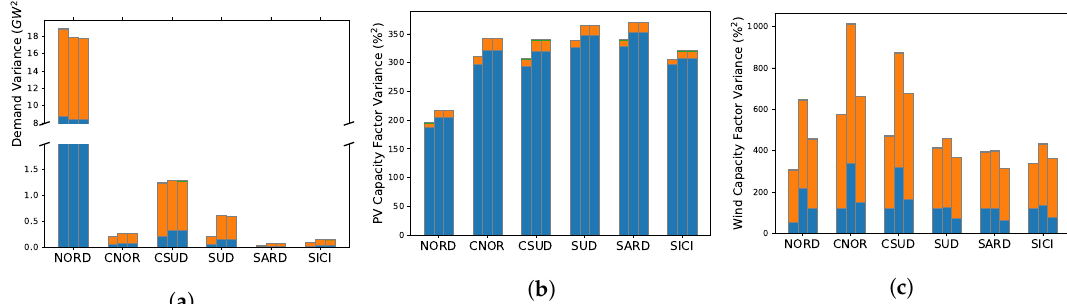
Figure 7. Decomposition of the variance over 1989–2011 of the demand ( a ), PV capacity factors ( b ) and wind capacity factors ( c ) into intraday (blue), seasonal (orange) and interannual (green) frequency bands for CORDEX (left bars), MERRA-2 with 10 m winds (middle bars) and MERRA-2 with 50 m winds (right